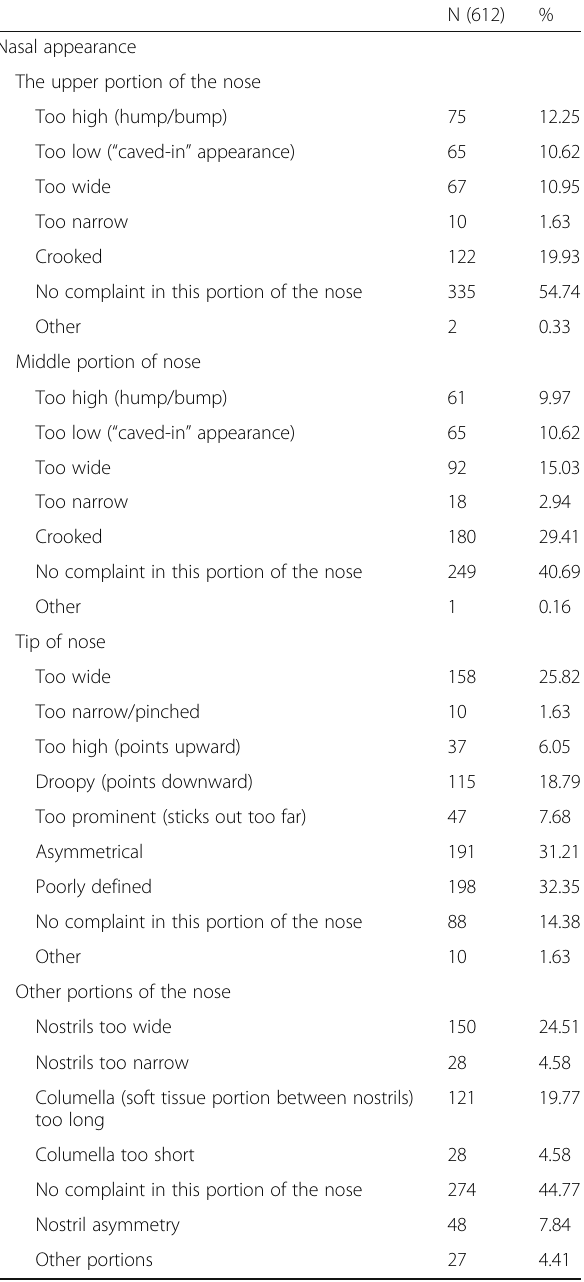
Table 2 Esthetic concerns (nasal appearance): upper, middle, tip, other